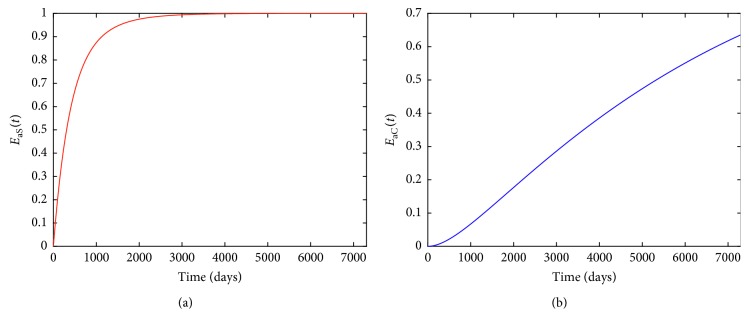
(a) Efficacy function EaS(t) for strategy a; (b) efficacy function EaC(t) for strategy a.